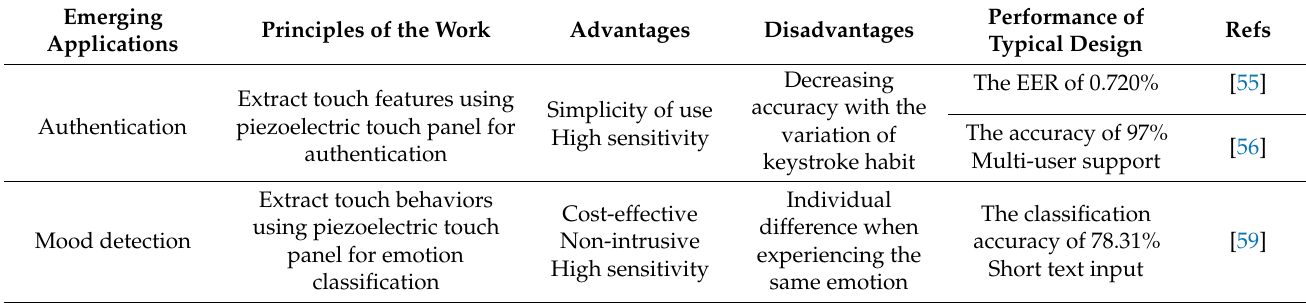
Table 4. Emerging applications based on the piezoelectric touch